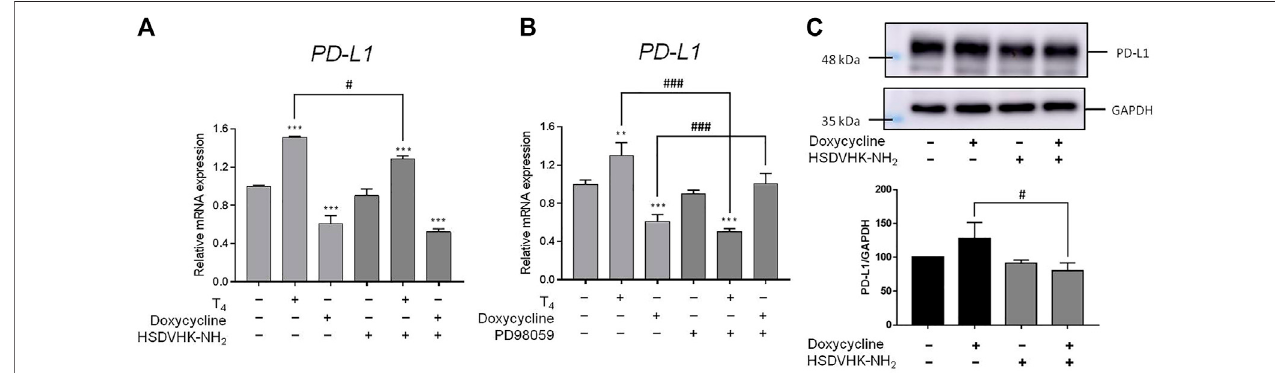
FIGURE6| Integrin α v β 3andERK1/2collaboratetothyroxine-ordoxycycline-induced PD-L1 expressioninbreastcancerMDA-MB-231cells.MDA-MB-231cells were pre-treated with (A) HSDVHK-NH 2 (10 µM) or (B) PD98059 (25 µM) for 24 h, then treated with T 4 (100 nM) or doxycycline (60 µM) for 24 h. Cells were harvested. RNA was extracted for qPCR. Numbers of independent studies ( n ) = 3. ANOVA was used to assess statistical signi fi cance. ** p < 0.01, *** p < 0.001, compared to the untreated control. # p < 0.05, ### p < 0.001, compared to doxycycline or T 4 treatment alone. (C) MDA-MB-231 cells were pre-treated with HSDVHK-NH 2 (10 µM) for24 h,thentreatedwithdoxycycline(60 µM)for24 h.CellswereharvestedandproteinwasextractedforPD-L1expressionanalysis.Numbersofindependentstudies ( n ) = 3. ANOVA was used to assess statistical signi fi cance. # p < 0.05, compared to doxycycline